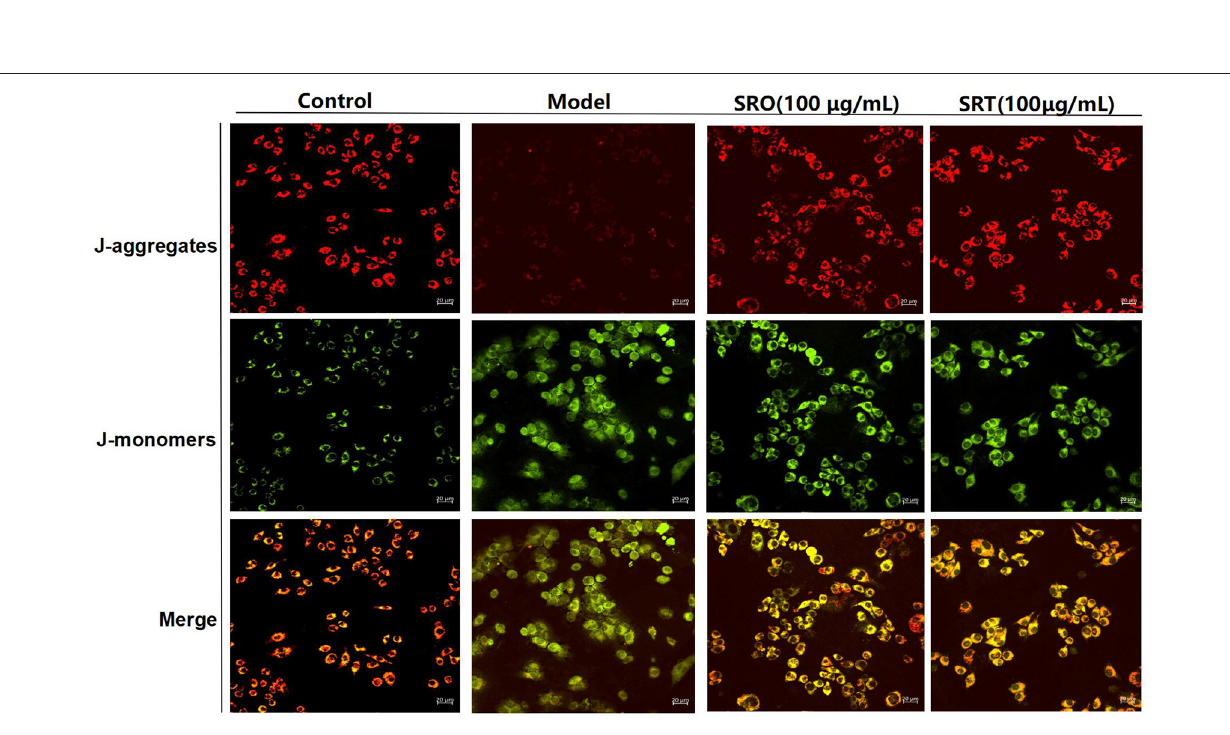
Frontiers in Nutrition |